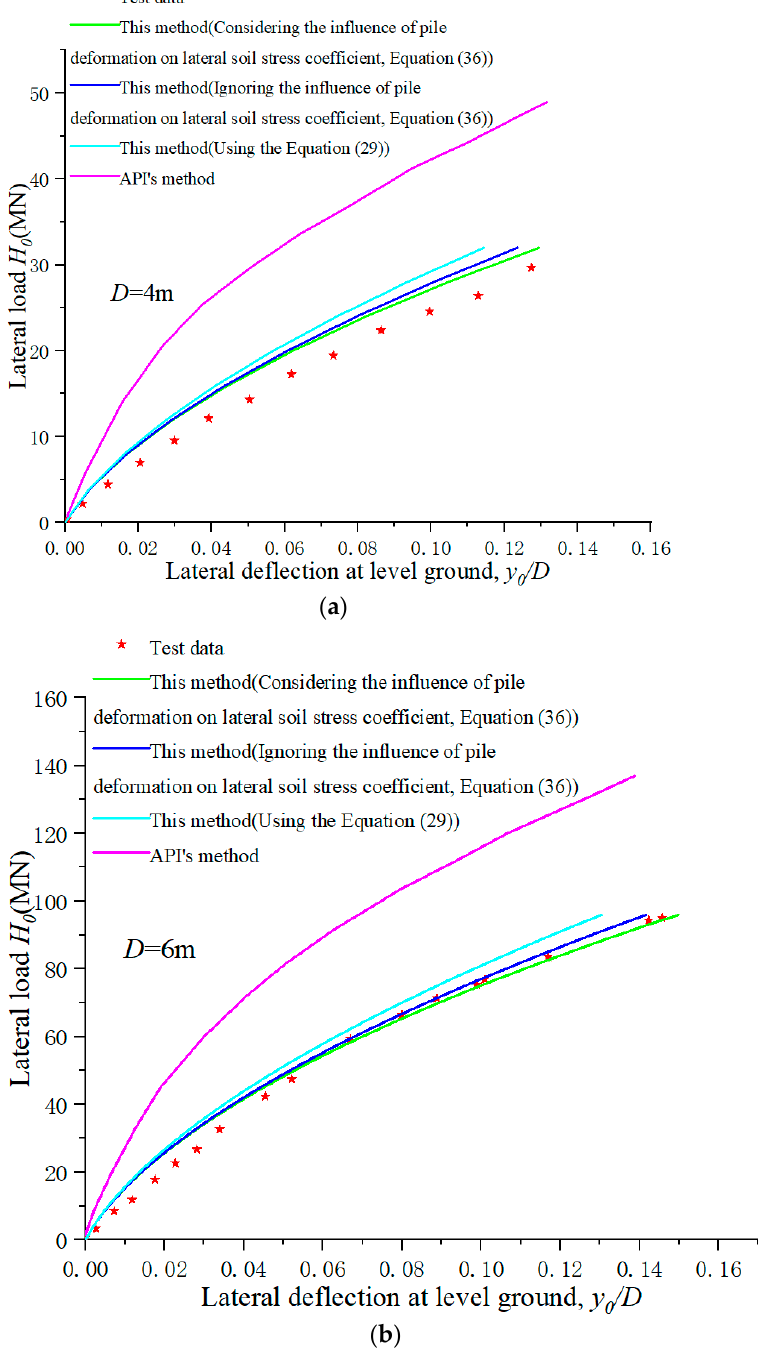
Figure 8. Comparison with load-de fl ection test results at level ground: ( a ) D = 4 m; ( b ) D = 6 m.